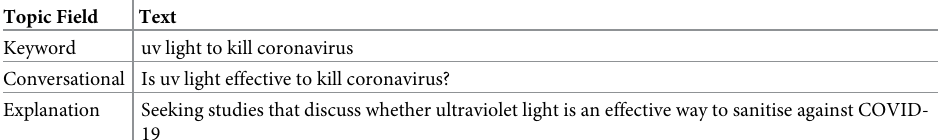
Table 2. The keyword, conversational, and explanation fields for the MLIA query topic about the use of ultraviolet light to kill